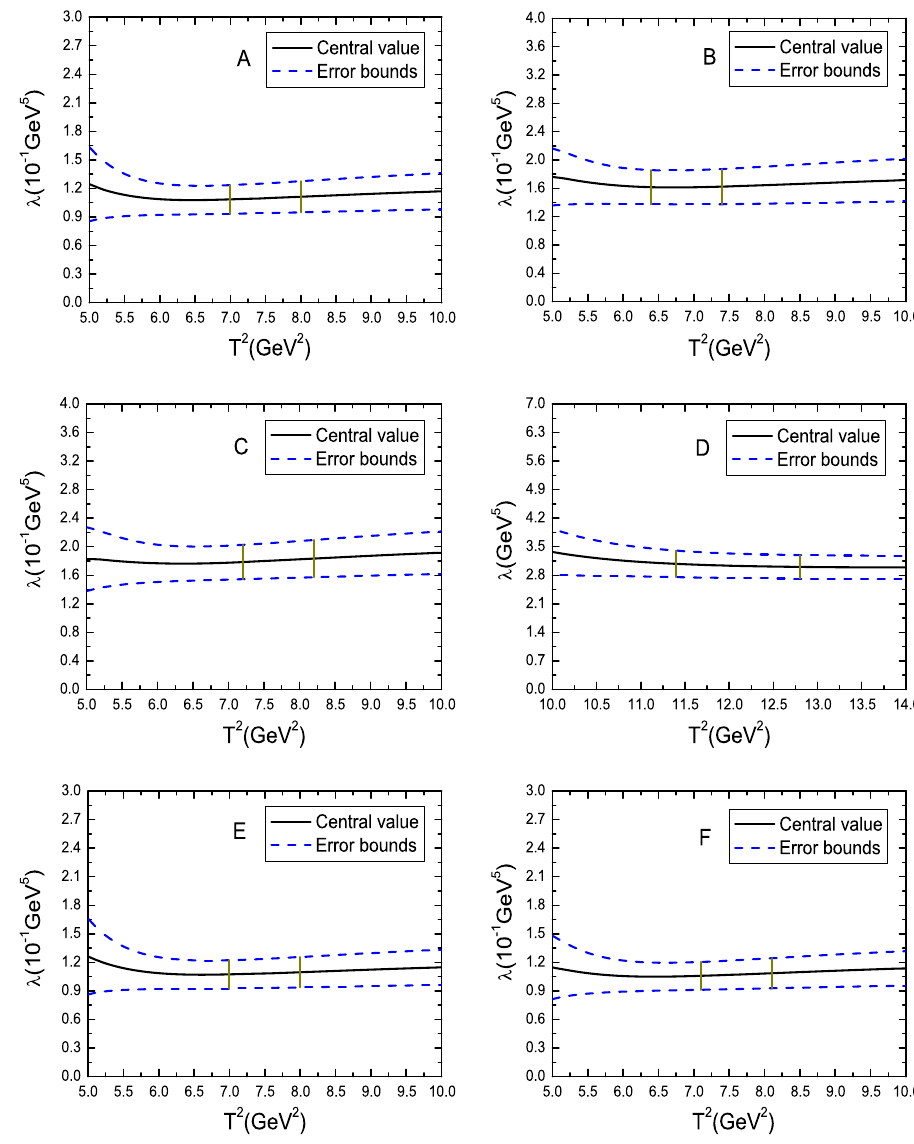
Fig. 3 The pole residues with variations of the Borel parameters T 2 for the hidden-bottom tetraquark states, the A , B , C , D , E and F denote the tetraquark states [ ub ] S [ db ]